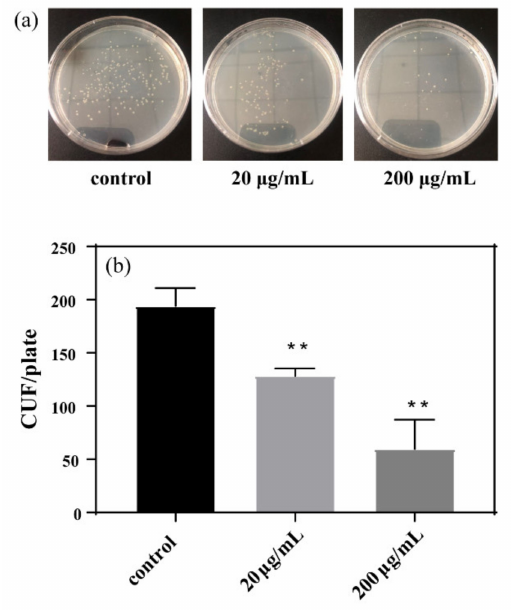
Figure 2. The result of bacteriostatic experiments after 24 h of culture ( a ) and the count of plaque of E. coli ( b ) (The initial E. coli solution OD 600 is 0.1) (** p < 0.01). The survival rate of E. coli also decreased with increasing GORs concentration (Figure 3), that GORs exert a dose-dependent toxic effect on E. coli .